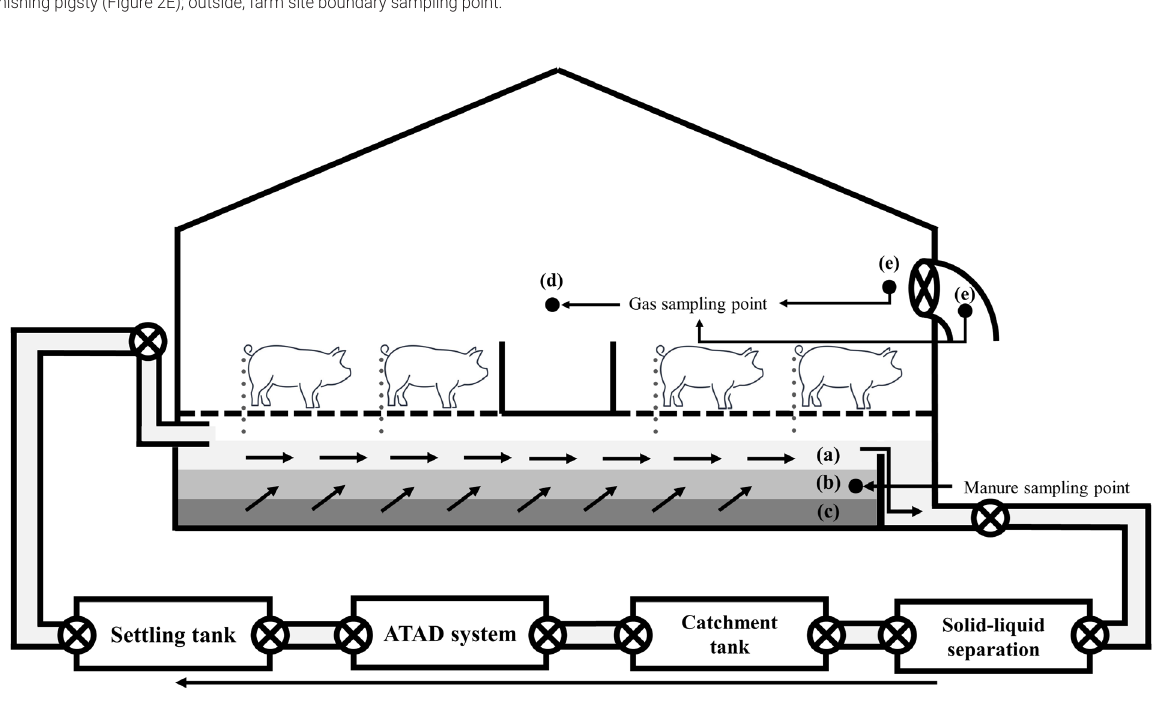
Figure 2. Schematic diagram of the experimental farm facilities with a continuous pit recirculation system. (a) 40 to 60 cm; (b) 20 to 40 cm; (c) under 0 to 20 cm; (d) indoor gas sampling point; (e) exhaust fan sampling